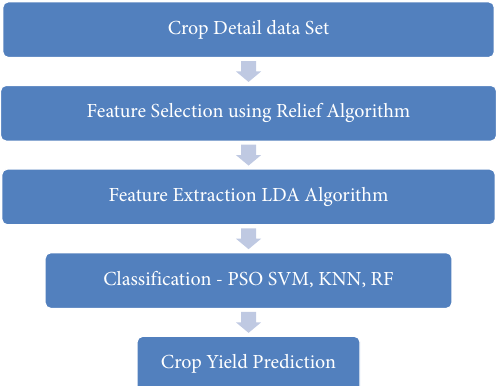
Figure 1: Machine learning-enabled framework for accurate crop yield